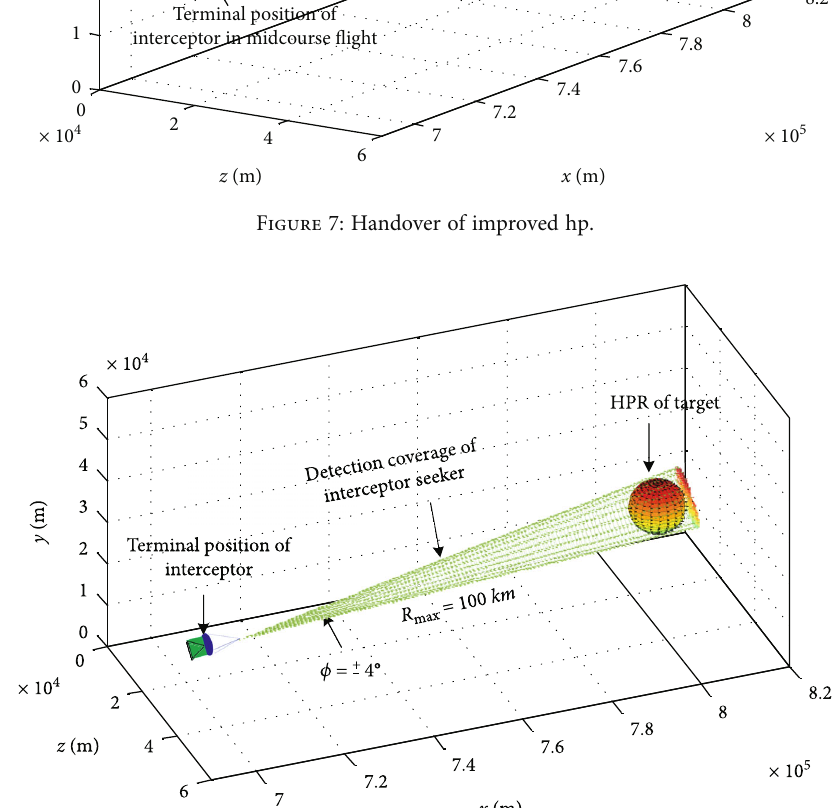
Figure 8: Handover of